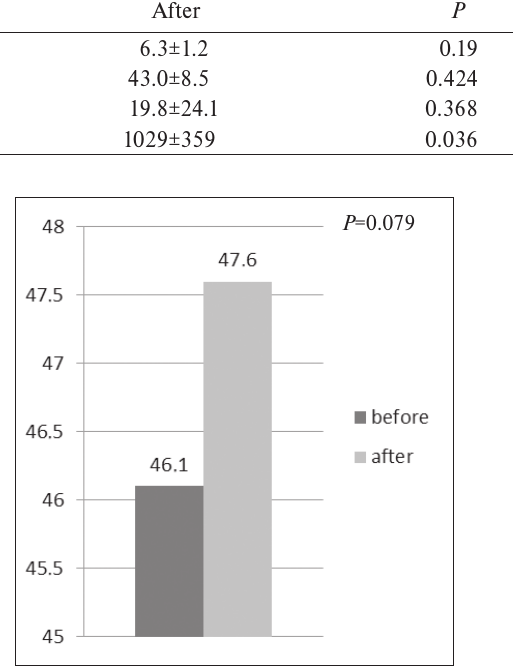
Fig. 1A. Changes in fasting glucose (mmol/L). Fig. 1B. Changes in glycated hemoglobin (mmol/mol).